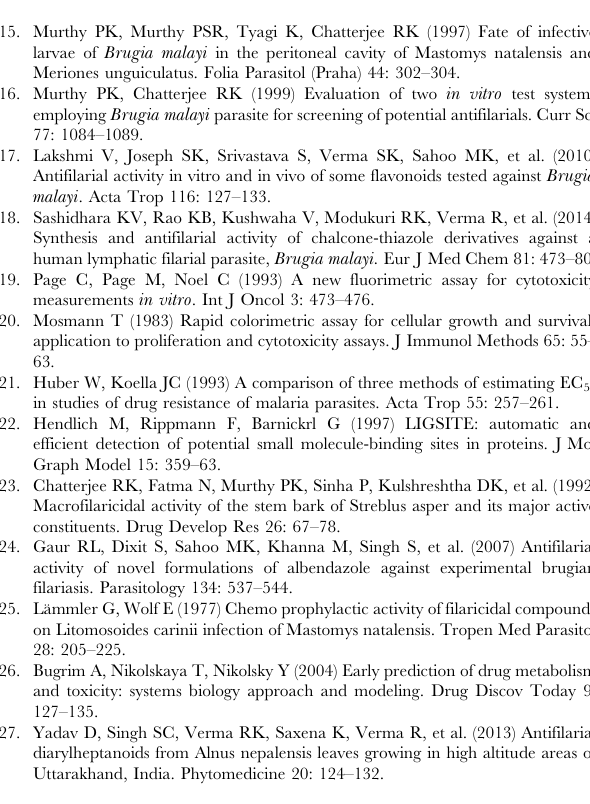
in motility assay using mf ( A ) and adult female worms ( B ) and in MTT reduction assay using adult female worms ( C ). (TIF) Figure S2 LC 100 and IC 50 of diethylcarbamazine citrate (DEC-C) for microfilariae and adult parasites of B. malayi . After incubation with DEC-C for 24 h the viability of parasite was assessed in motility assay using mf ( A ) and adult female worms ( B ) and in MTT reduction assay using adult female worms ( C ). (TIF) Figure S3 LC 100 and IC 50 of ivermectin for microfilariae and adult parasites of B. malayi . After incubation with ivermectin for 24 h ( A–C ) and 48 h ( D–F ) the viability of parasite was assessed in motility assay using mf ( A, D ) and adult female worms ( B, E ) and in MTT reduction assay using adult female worms ( C, F ). (TIF) File S1 Linear Trend analysis of mf count data.